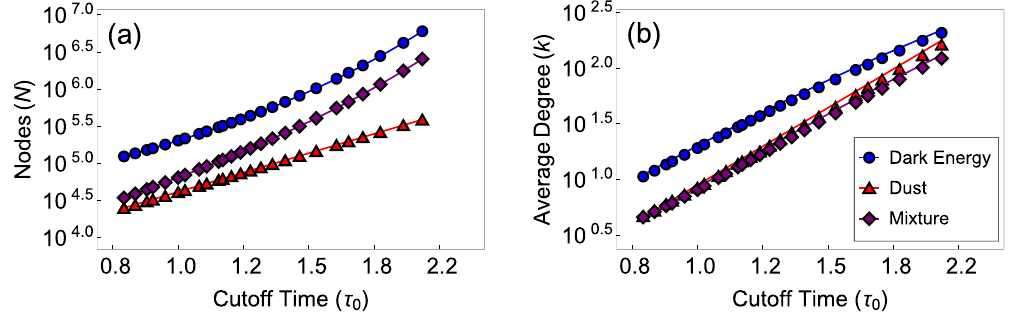
Figure 2. Graph size and average degree as functions of the cutoff time. The figure shows the graph size N and average degree k in simulations versus theoretical predictions, the solid curves, given by (8, 10), for the constant rescaled sprinkling density q = 60 and spatial cutoff ρ 0 =